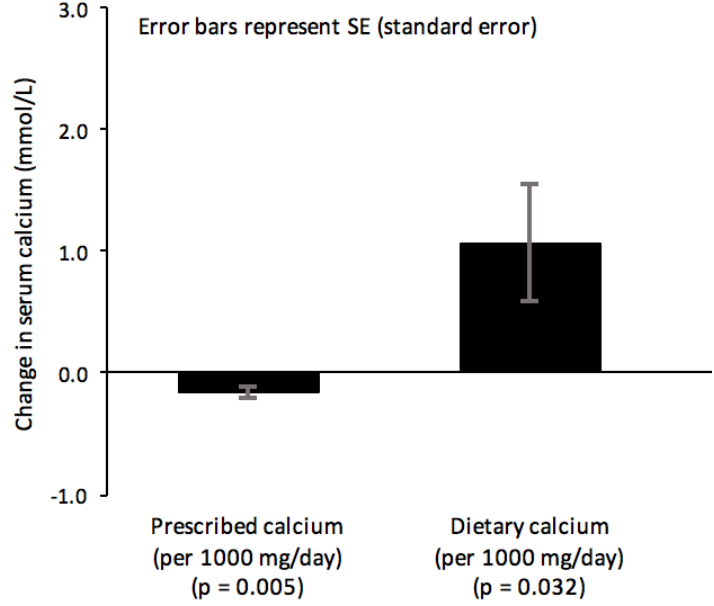
Figure 3. Changes in serum calcium as a function of sources of calcium.